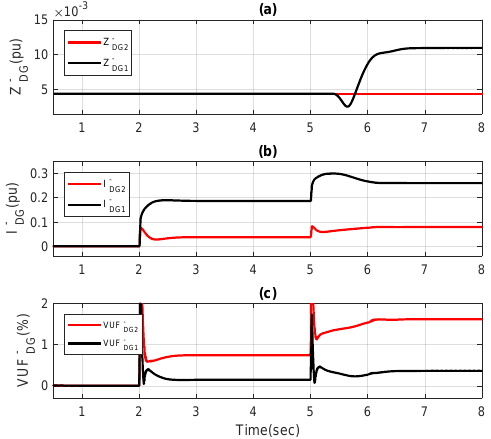
Figure 12. Negative-sequence ( a ) output impedance, ( b ) current, and ( c ) VUF of DG units.